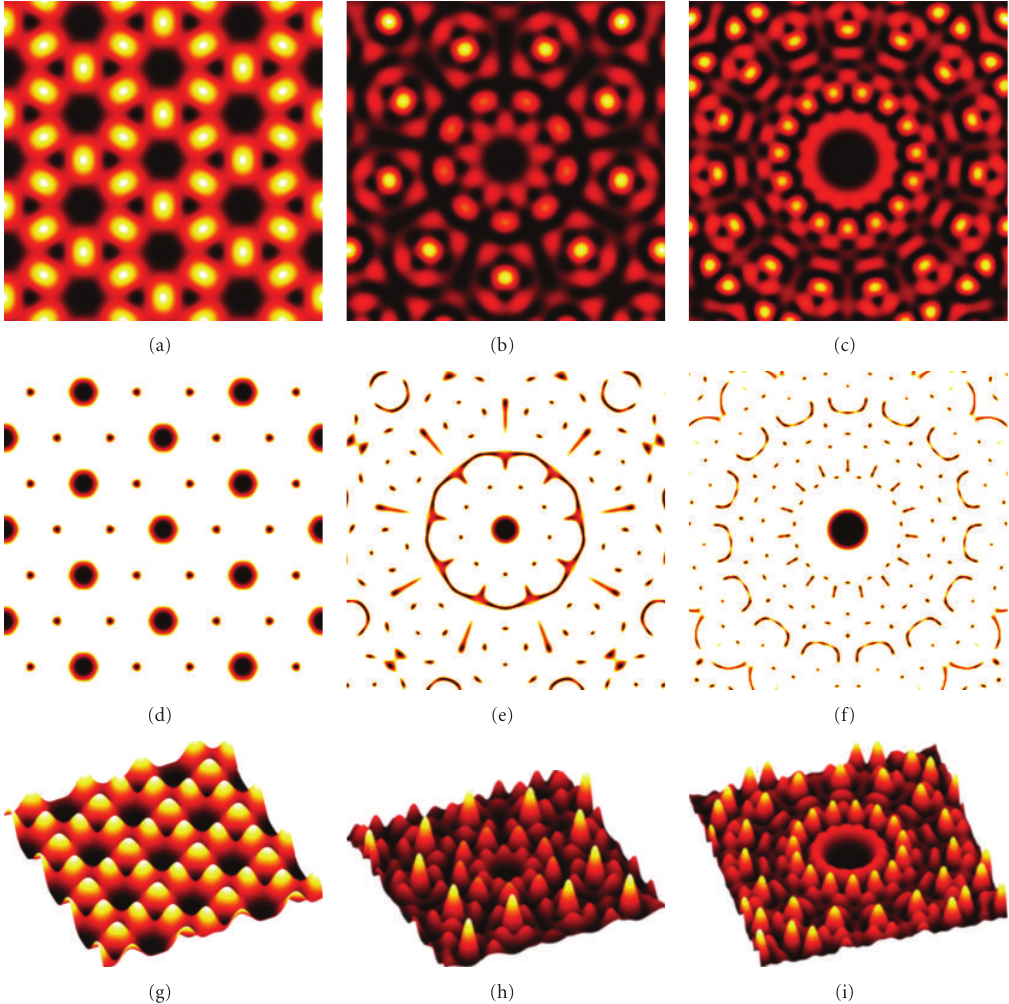
Figure 2: Simulation of complex 2D vortex lattice intensity profile possessing a distribution of higher-order topological charged as well as single charged vortices. Taking the multiples of relatively phase-shifted three beams, the numbers of interfering beams involved are, respectively 6 beams (first column), 9 beams (second column), and 15 beams (third column). (a)–(c) Intensity distribution in x - y plane. (d)–(f) Intensity distribution with a lower threshold value in order to high light the darker regions alone. (g)–(i) Intensity mesh